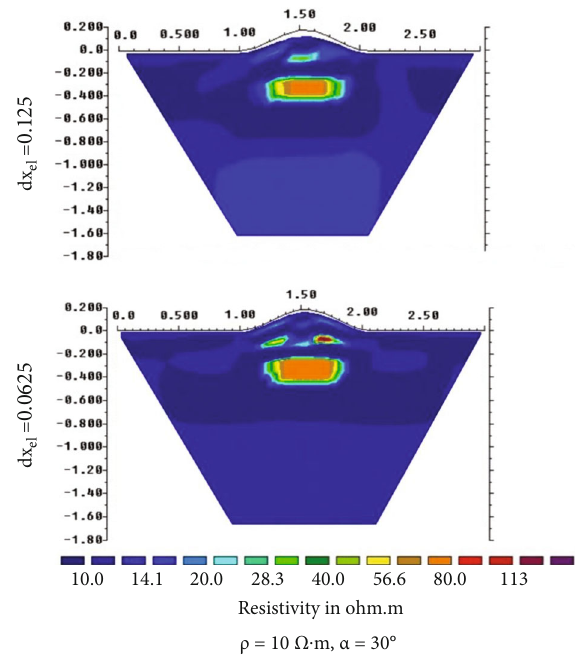
Figure 12: The in fl uence of the distance between the measuring electrodes on 3D topographic e ff